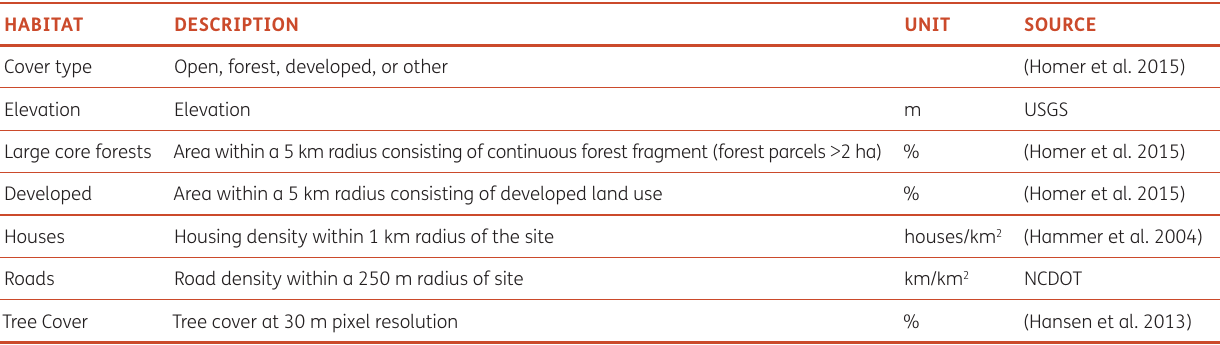
Table 1 Habitat variables considered for the analysis of how representative the data were of the state.